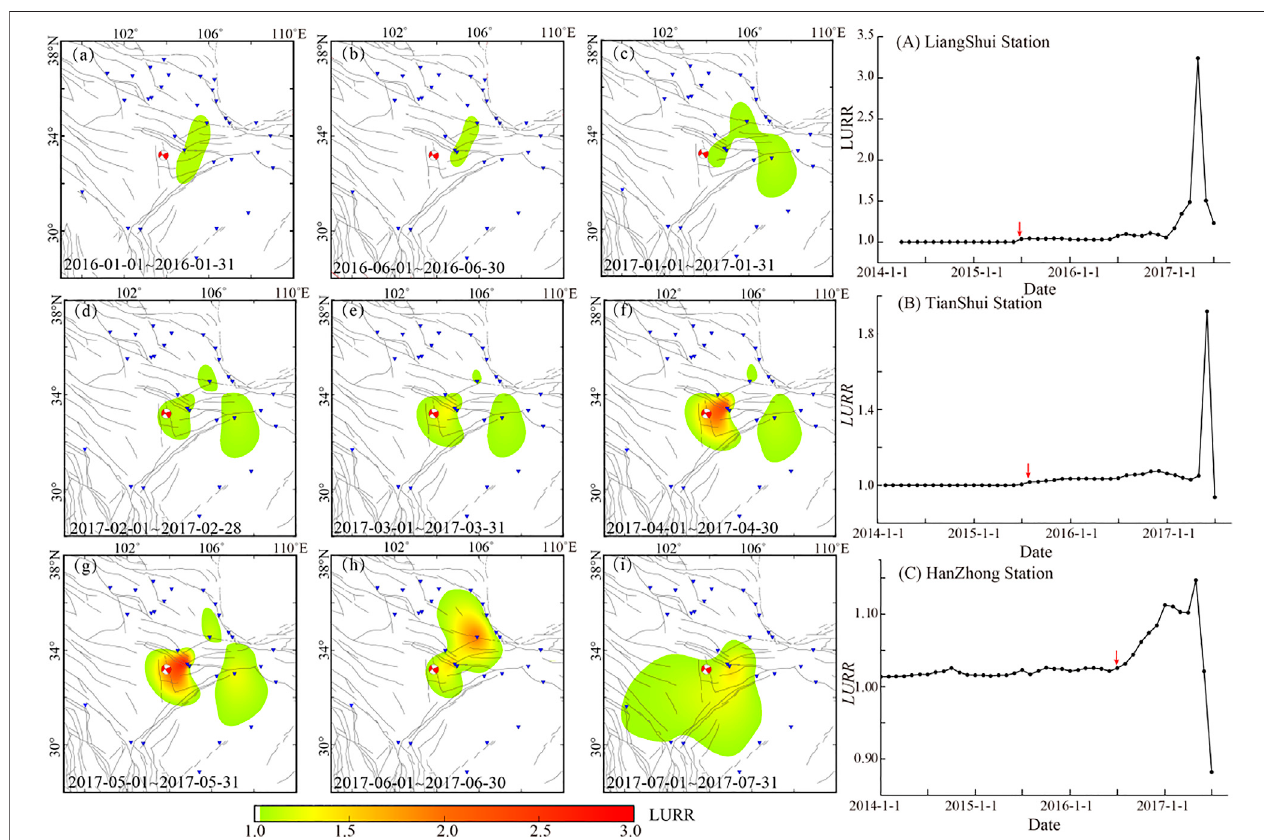
FIGURE 3 | LURR spatial distribution (a – i) and LURR time series of different stations (A – C) . (a – i) Spatial distribution of some periods from January 2016 to July 2017; Blue triangle: strain stations; Red focal mechanism solution: JZGEQ; Gray lines: fault. (A – C) LURR time series results for the L-Sh station, T-Sh station, and H-Zh station, respectively. Parameters for LURR evaluation are as follows: strike = 151, dip = 85, rake = 0, and depth = 15 km (Sun et al., 2018); Red arrow: start time of the anomaly.